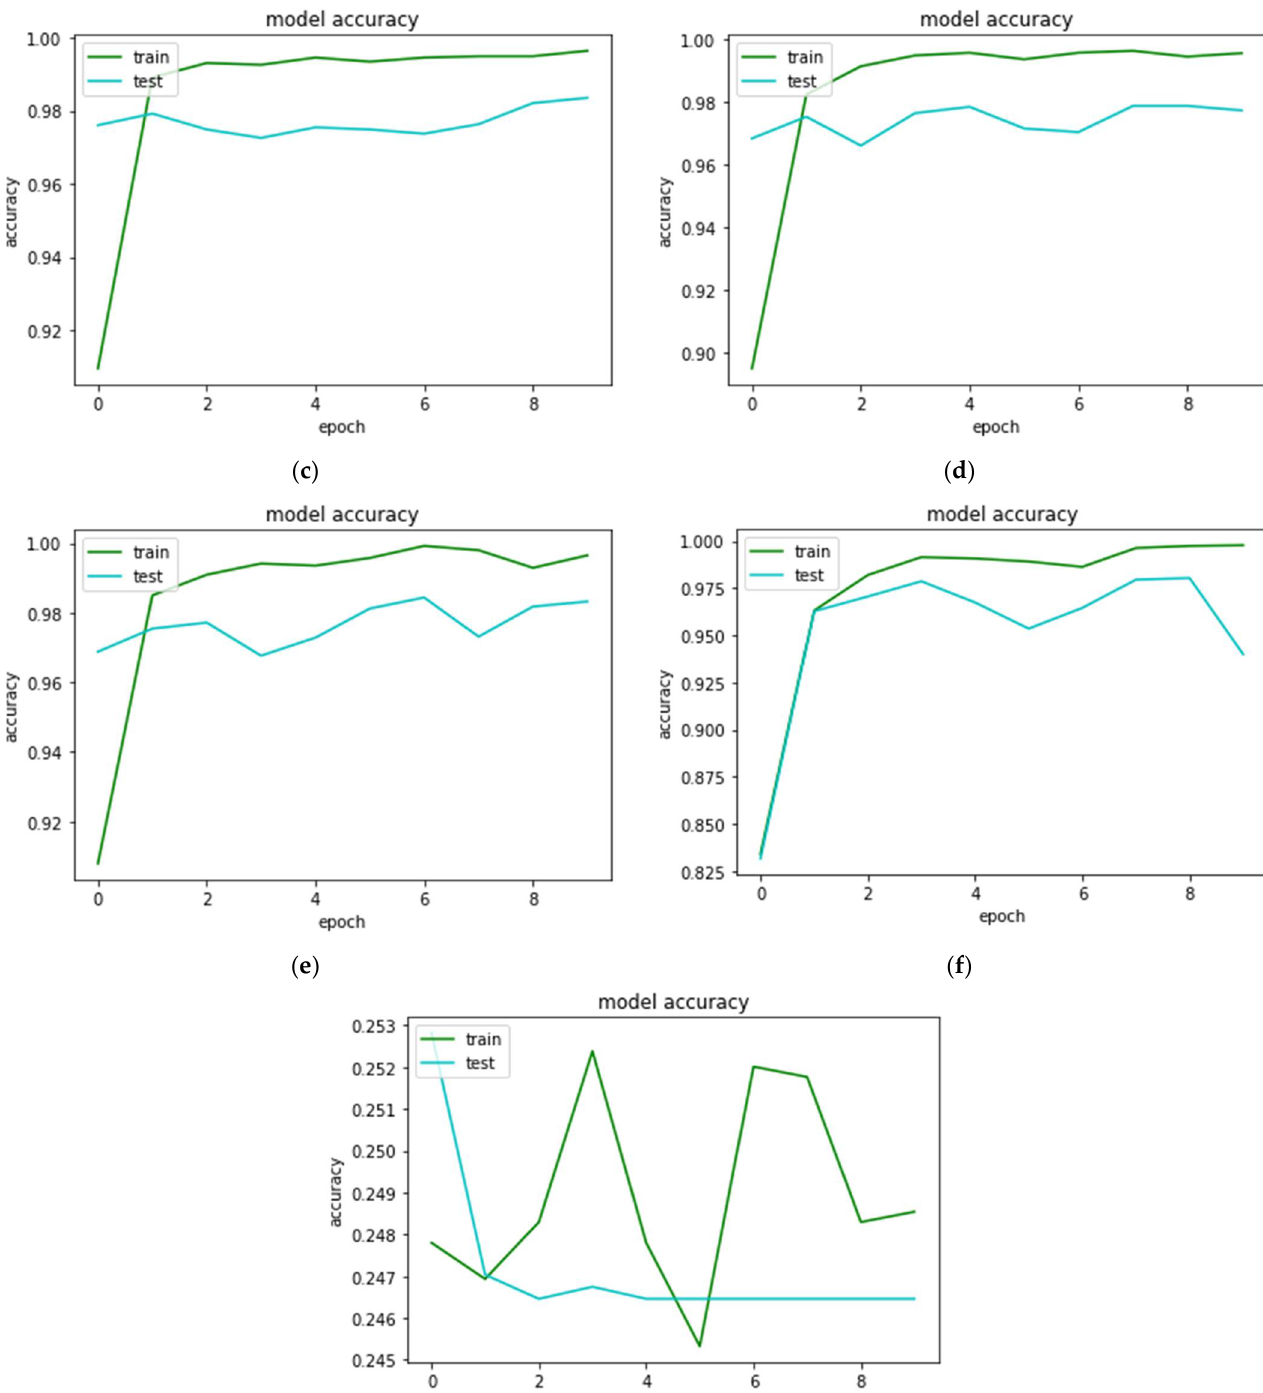
Figure 3. Training and validation accuracy curves of: ( a ) convolutional neural network, ( b ) DenseNet201, ( c ) EfficientNetB2, ( d ) EfficientNetB0, ( e ) InceptionV3, ( f ) ResNet152, and ( g ) VGG19 models, correspondingly, for the facemask coverage classification task.